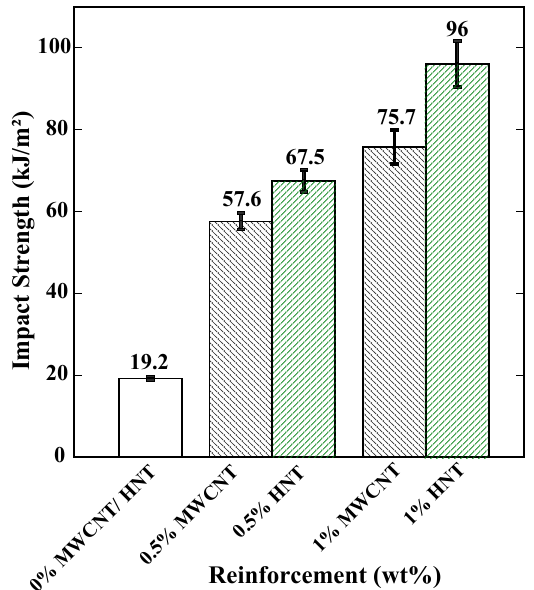
Figure 12. Impact test results of 4D-printed pure SMPU and reinforced